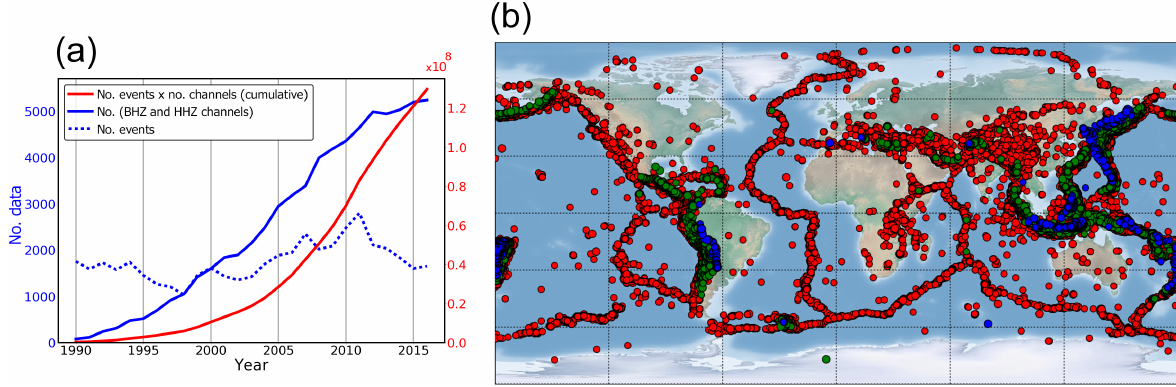
Figure 1. obspyDMT --datapath iris_events_dir --min_date 1990-01-01 --max_date 2017-01-01 --min_mag 5.0 --event_info --plot_seismicity Rapid growth of seismological waveform data holdings at international data centers since 1990. Using the obspyDMT command above, we queried the IRIS DMC for hour-long, vertical, broadband (BHZ and HHZ) waveform segments containing earthquakes exceeding a magnitude of 5.0. (a) The data center’s response. Red line shows cumulative sum of available event-based waveforms for this request; (cid:2) num_events (y) × num_channels (y) (cid:3) . Number of events and seismograms in each year are shown by dotted and solid blue lines, P year y = 1990 respectively. (b) Global seismicity map of earthquakes in panel (a) colored by depth. Red: 0–70km; green: 70–300km; blue: ≥ 300km. The generation of this map is triggered by the --plot_seismicity flag. Upon startup of the plotting module, the user can select the map style, “Shadedrelief” in this